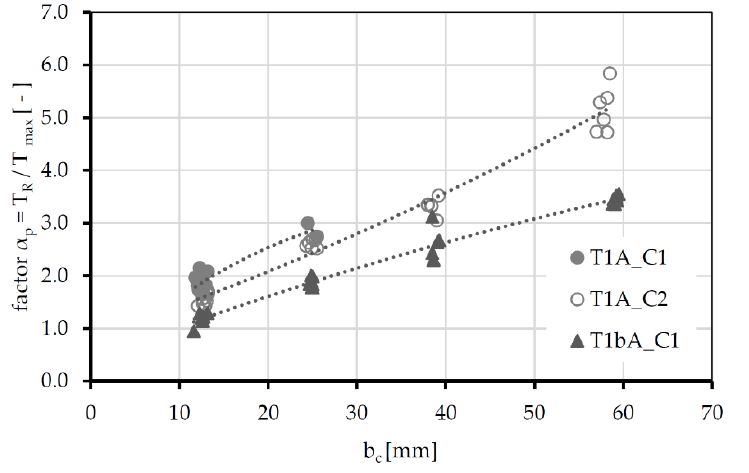
Figure 11. Dependence of the α p ‐ factors on the concrete width per fiber strand (b c ); assumption γ = 1.0 (Equation (1)).